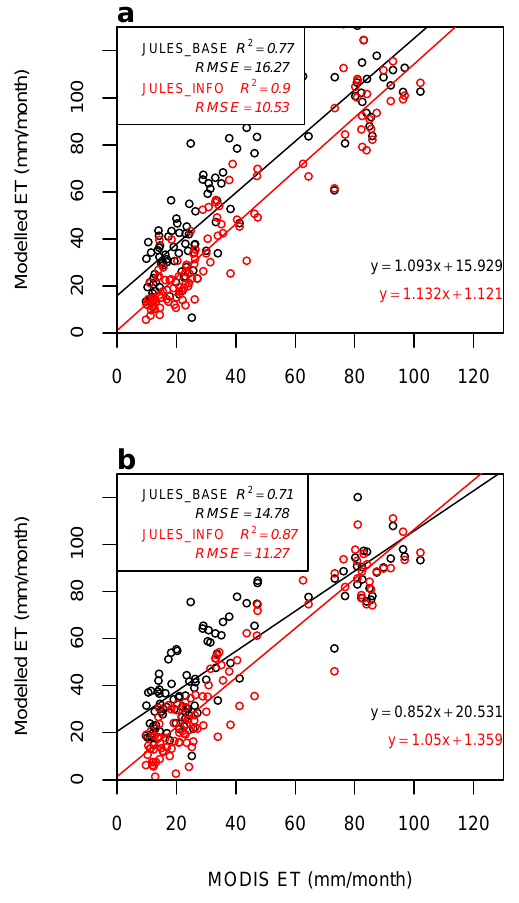
Figure 6. Performance scores of the two models (JULES-base and JULES-Info) in comparison with MODIS ET: (a) is with GMAO forcing data and (b) with TRMM and NCEP forcing